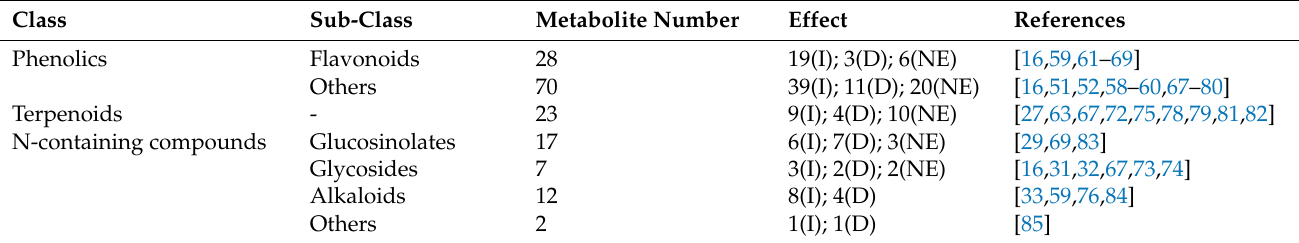
Table 2. Effects of elevated CO 2 on plant secondary